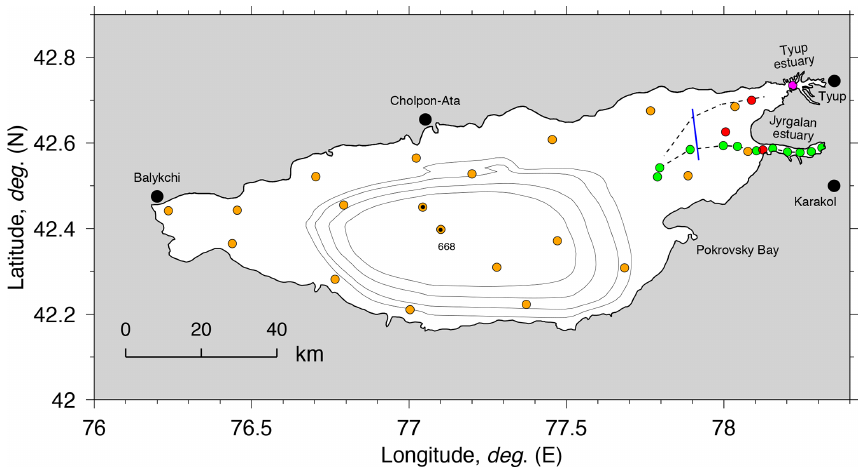
Figure 1. Map of Lake Issyk-Kul with schematized bathymetry contours 200, 300, 400, and 500m, and hydrographic stations occupied during the field campaigns of June 2015, November 2016, and June 2017. Most stations were occupied during all surveys (orange bullets). Green bullets show stations occupied only once in 2016, and the magenta bullet depicts the station occupied only once in 2017. The red bullets mark the locations of the mooring stations. The orange bullets with dots inside refer to the deepest stations; see Fig. 2. The dashed lines in the eastern part of the lake indicate the paleo-beds of the Jyrgalan and Tyup rivers; see the text for details. The blue segment shows the location of bathymetric transect discussed in Sect. 3.4 and depicted in Fig.